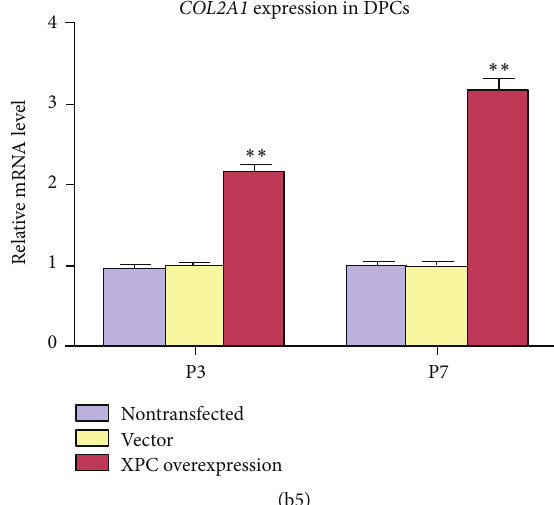
Figure 5: Effect of XPC on the multilineage differentiation capability of DPCs after transfection. After 21 d of multilineage differentiation induction, immunofluorescent staining indicated that DSPP (a1), LPL (a2), and collagen type II (a3) were extensively expressed in DPCs at P7 with XPC overexpression, strongly expressed in the nucleus and moderately expressed in the cytoplasm of DPCs. However, DSPP (a4), LPL (a5), and collagen type II (a6) revealed weak expression in the nucleus and cytoplasm of DPCs at P7 without transfection. Real-time PCR indicated that mRNA expression level of odontogenic markers ( DMP1, DSPP ), adipogenic markers ( PPAR 𝛾 2, LPL ), and chondrogenic markers ( collagen type II ) increased significantly in DPCs at P3 and P7 with XPC overexpression compared with vector groups